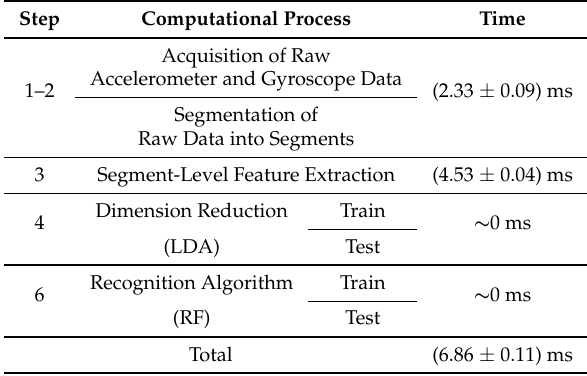
Table 7. Time consumption (Avg. ± SD) of every step in the recognition process for every